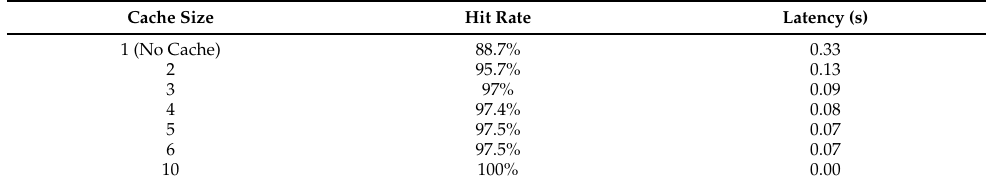
Table 2. Performance of transition-probability-based model